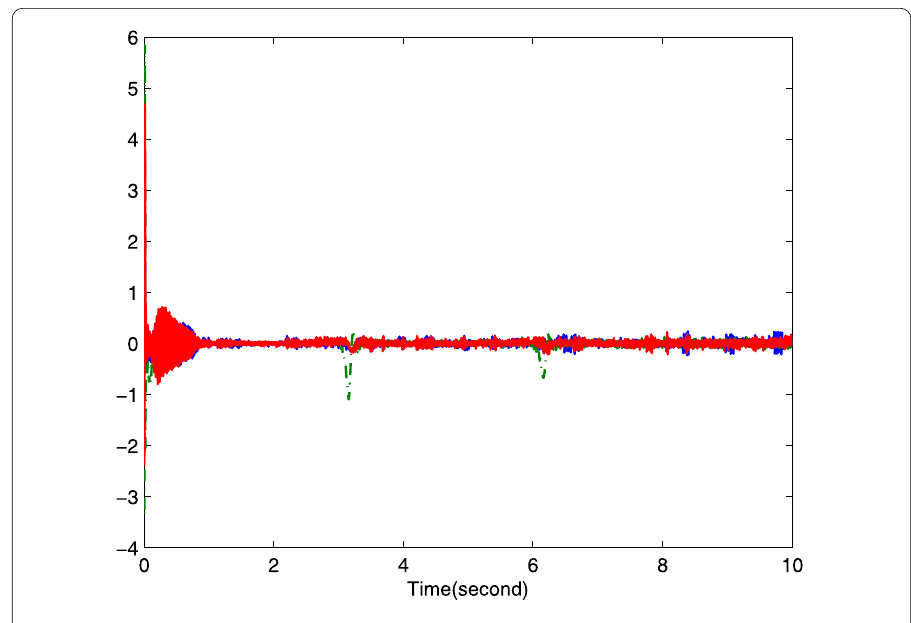
Figure 3 The synchronization error. e 1 ( t ) (Dotted line), e 2 ( t ) (chain line) and e 3 ( t ) (solid line)